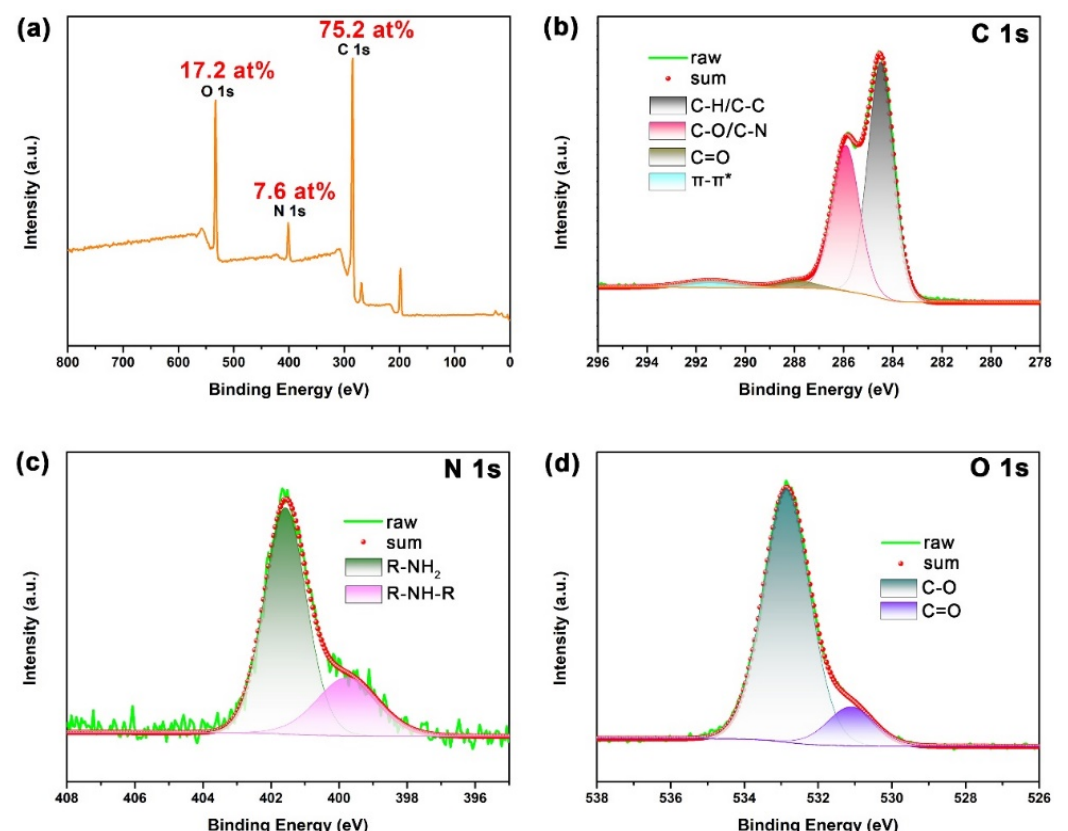
Figure 2. The XPS ( a ) survey spectrum of NCDs and high-resolution spectra for ( b ) C 1s, ( c ) N 1s and ( d ) O 1s.